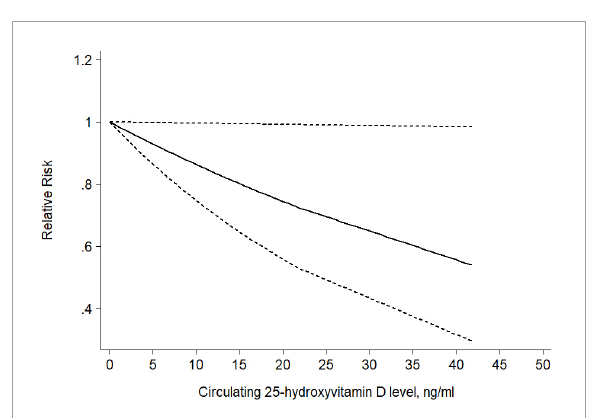
FIGURE10 Dose-response relationship between circulating 25(OH)D level and risk of CRC precursors incidence. Weights are from the fixed-effects analysis. Solid line represents the linear trend and short dashes line represent the 95%